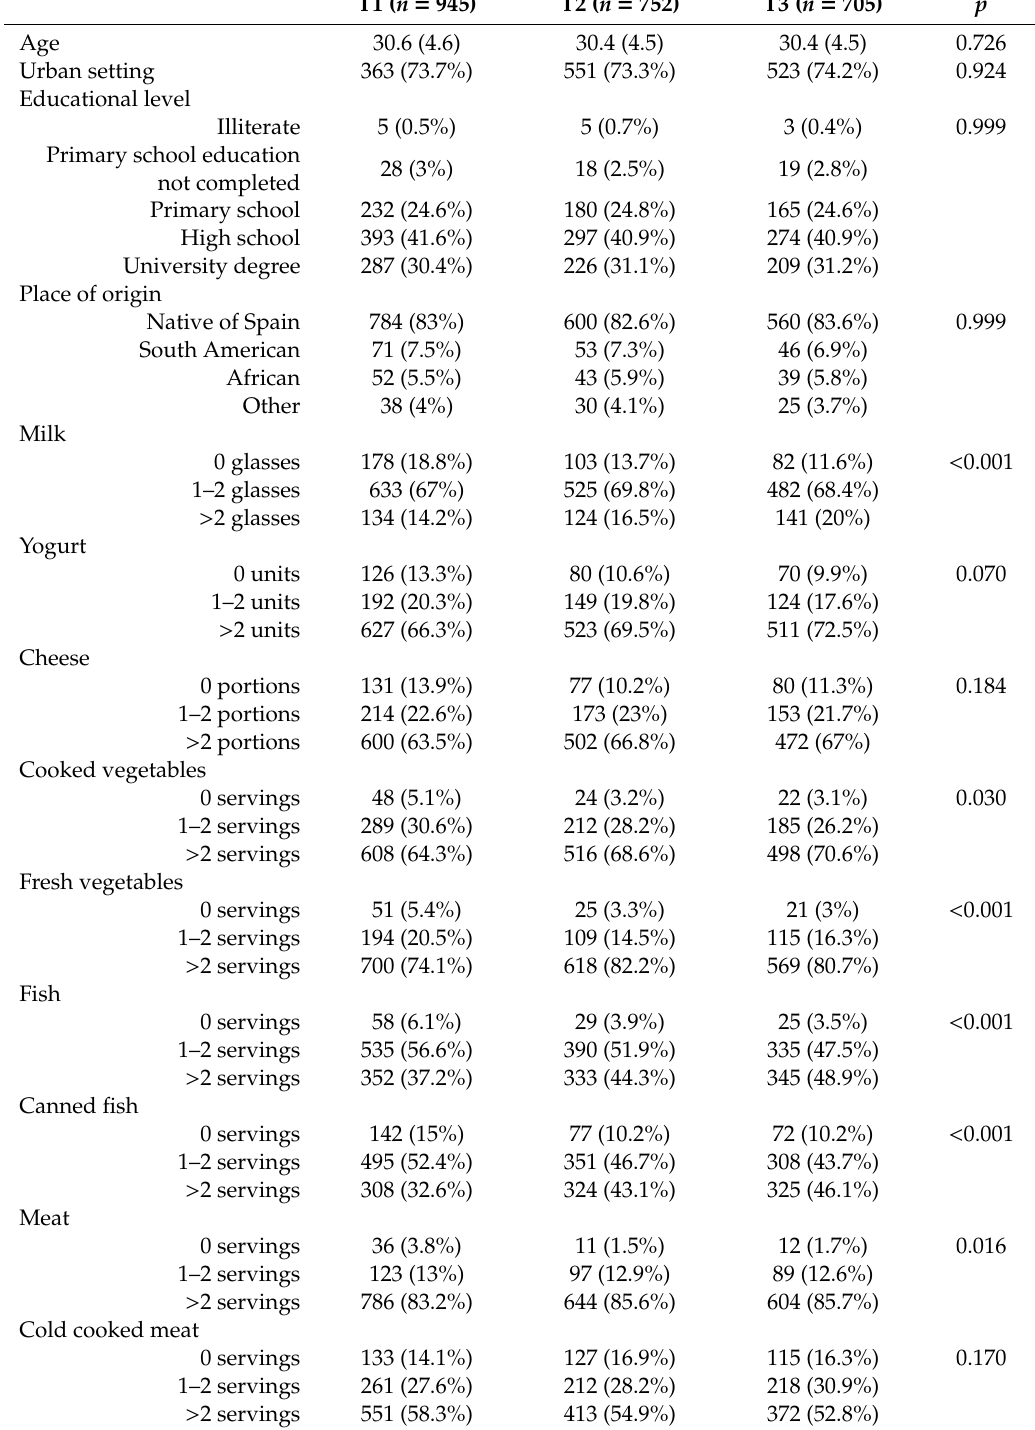
Table 1. Characteristics and habits of the participants based on their responses to the dietary